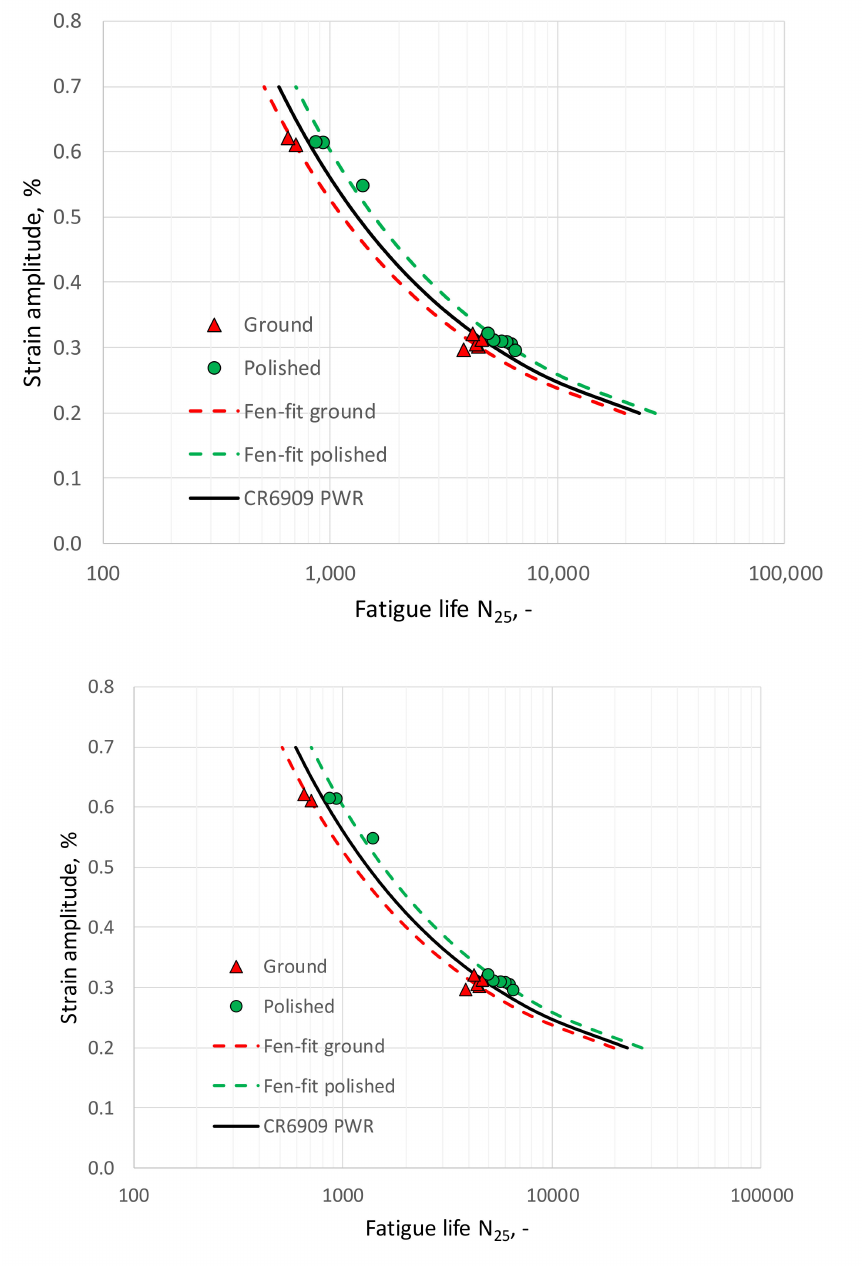
Figure 7. Primary water reactor (PWR) fatigue life results (by surface finish) and NUREG / CR6909 mean PWR curve at 300 ◦ C (Fen =